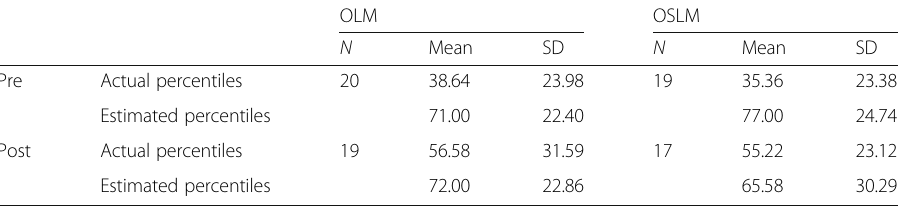
Table 6 The students ’ actual percentiles and estimated percentiles for the OLM and OSLM groups OLM